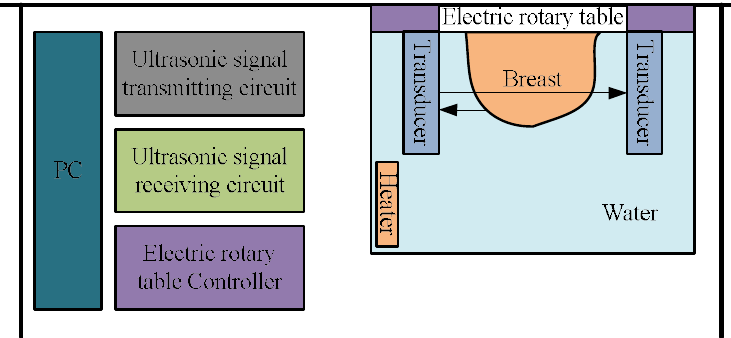
Figure 1. Diagram of the 3D ultrasound imaging ring system.